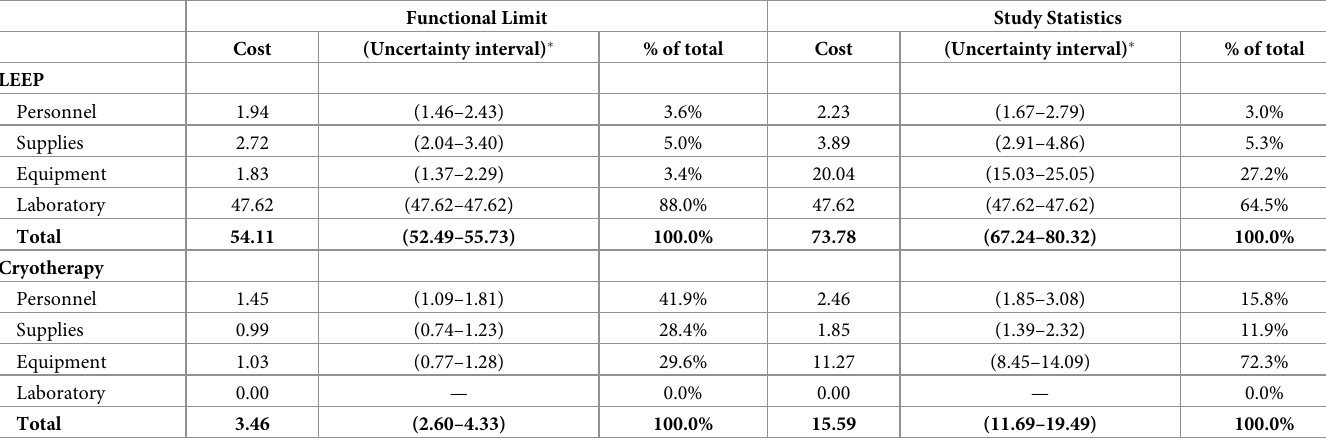
Table 4. Average estimated procedure costs, with cost breakdown, for each service volume scenario (USD 2015), intention-to-treat